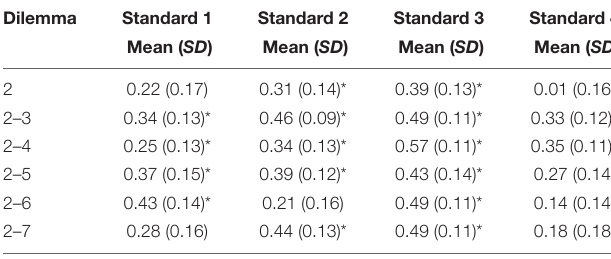
TABLE 6 | Bootstrapped correlations of (accumulated) gameplay data and IL score – final models.